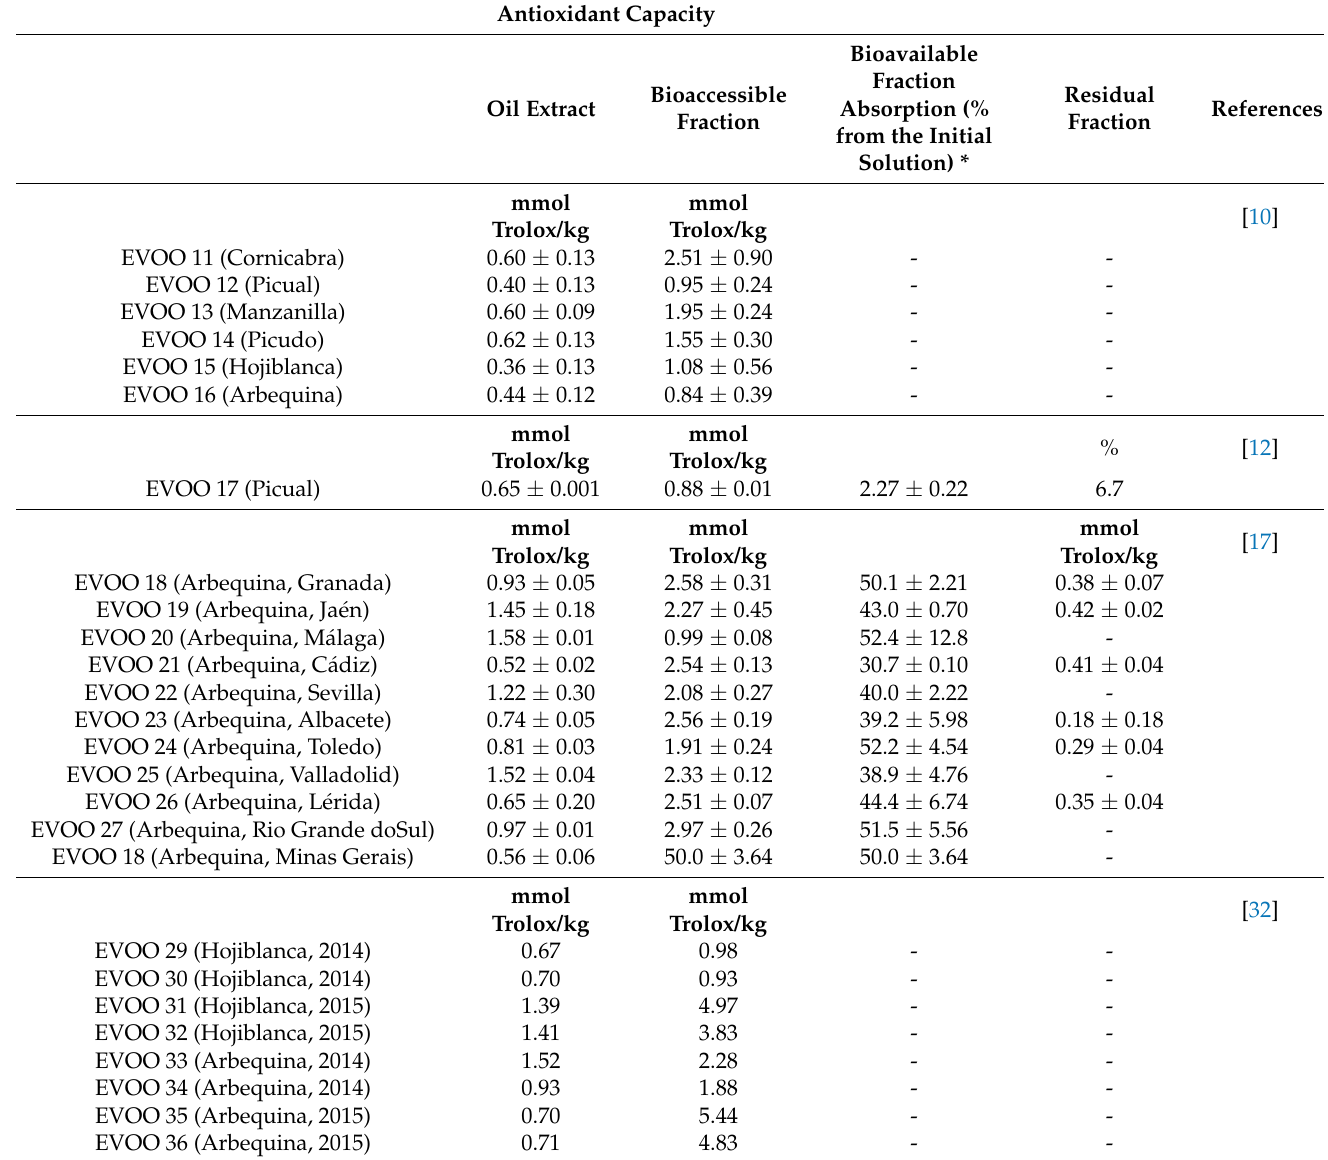
Table 3. Antioxidant capacity measured by the DPPH assay in the oil extracts and in the bioaccessible and bioavailable fractions after in-vitro digestion of the oil